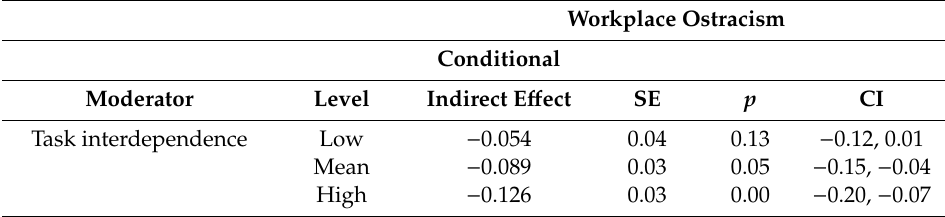
Table 4. Moderated mediation results for workplace ostracism across levels of task interdependence for task